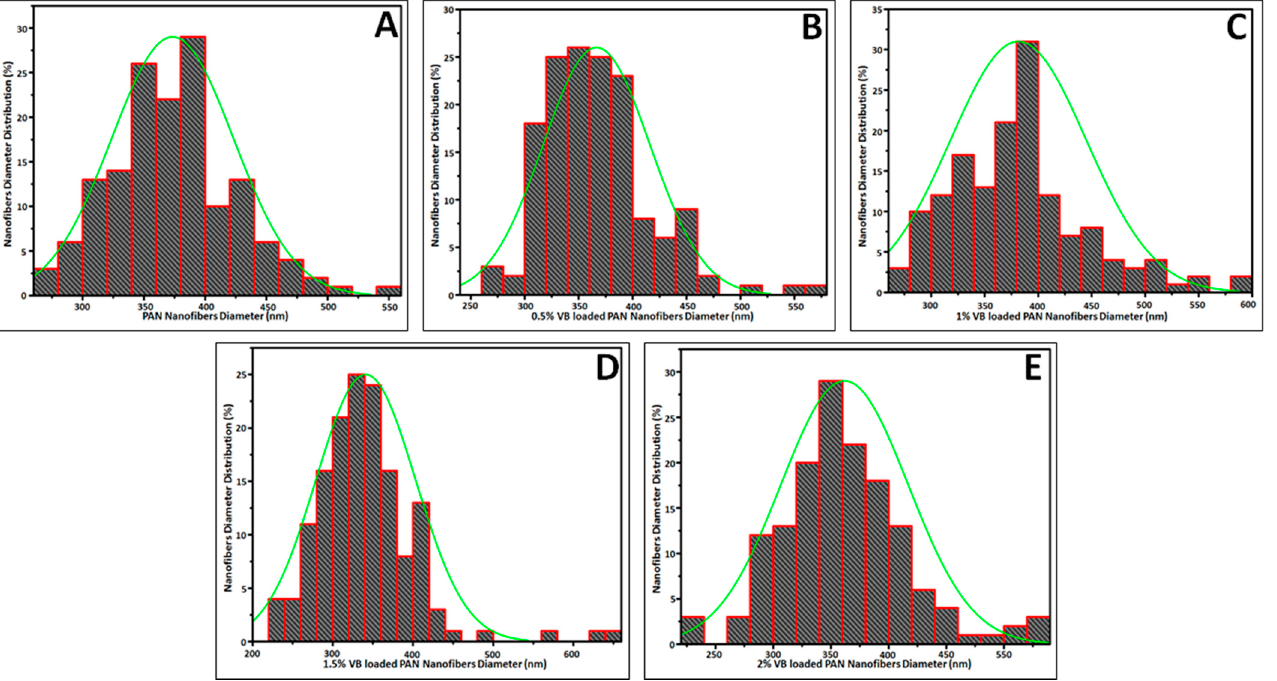
Figure 2. Diameter distribution curve: ( A ) pure PAN, ( B ) 0.5% VB/PAN, ( C ) 1% VB/PAN, ( D ) 1.5% VB/PAN, ( E ) 2% VB/PAN.